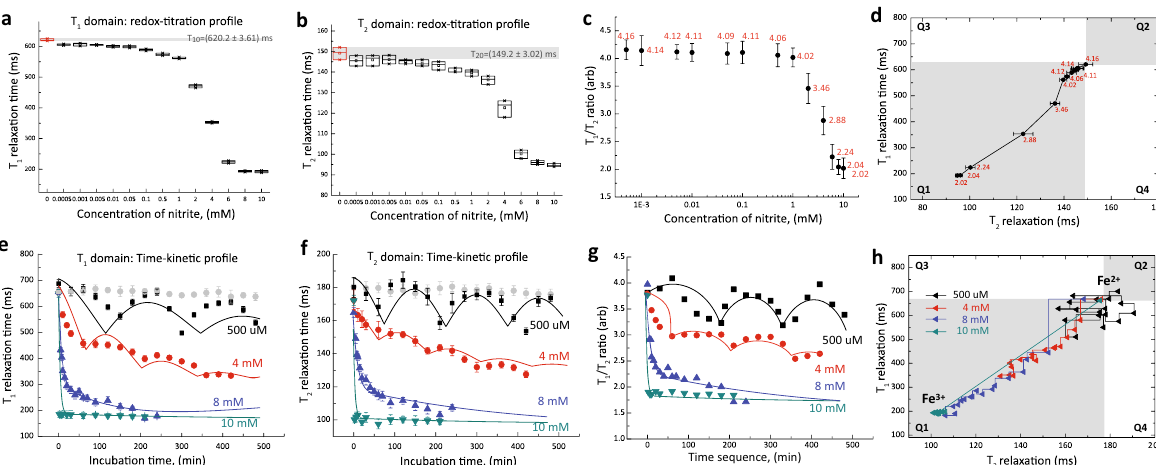
Fig. 2 Nitrite-induced ferrous oxidation. Redox-titration pro fi le of red blood cells as function of nitrite concentration in a T 1 relaxation and b T 2 relaxation domain. The incubation times were 10 min. The control baseline readings were ( T 2o = 149.5, T 1o = 621.3) ms, which is the readings for oxy-Hb without any nitrite exposure. The limit of detection (LOD) is about 0.0005 mM of nitrite concentration (gray bar). The data is represented by box-plot format. The corresponding concentration-dependent c A-ratio, and d T 1 – T 2 trajectories of the gradual inversion of Fe 2 + subpopulation to complete formation of Fe 3 + population. Time-dependent kinetic pro fi le of ferrous oxidation using nitrite concentrations (500 μ M, 4 mM, 8 mM, and 10 mM) in e T 1 relaxation and f T 2 relaxation domain. The corresponding g A-ratio, and h T 1 – T 2 trajectories in the magnetic state diagram. Three different samplings were taken from the same donor, and the results were reported as mean ± standard error measurement. For curve fi tting, a general function of exp( − Ct)|cos(Ct)| can be used to describe the oscillatory behavior, where C is